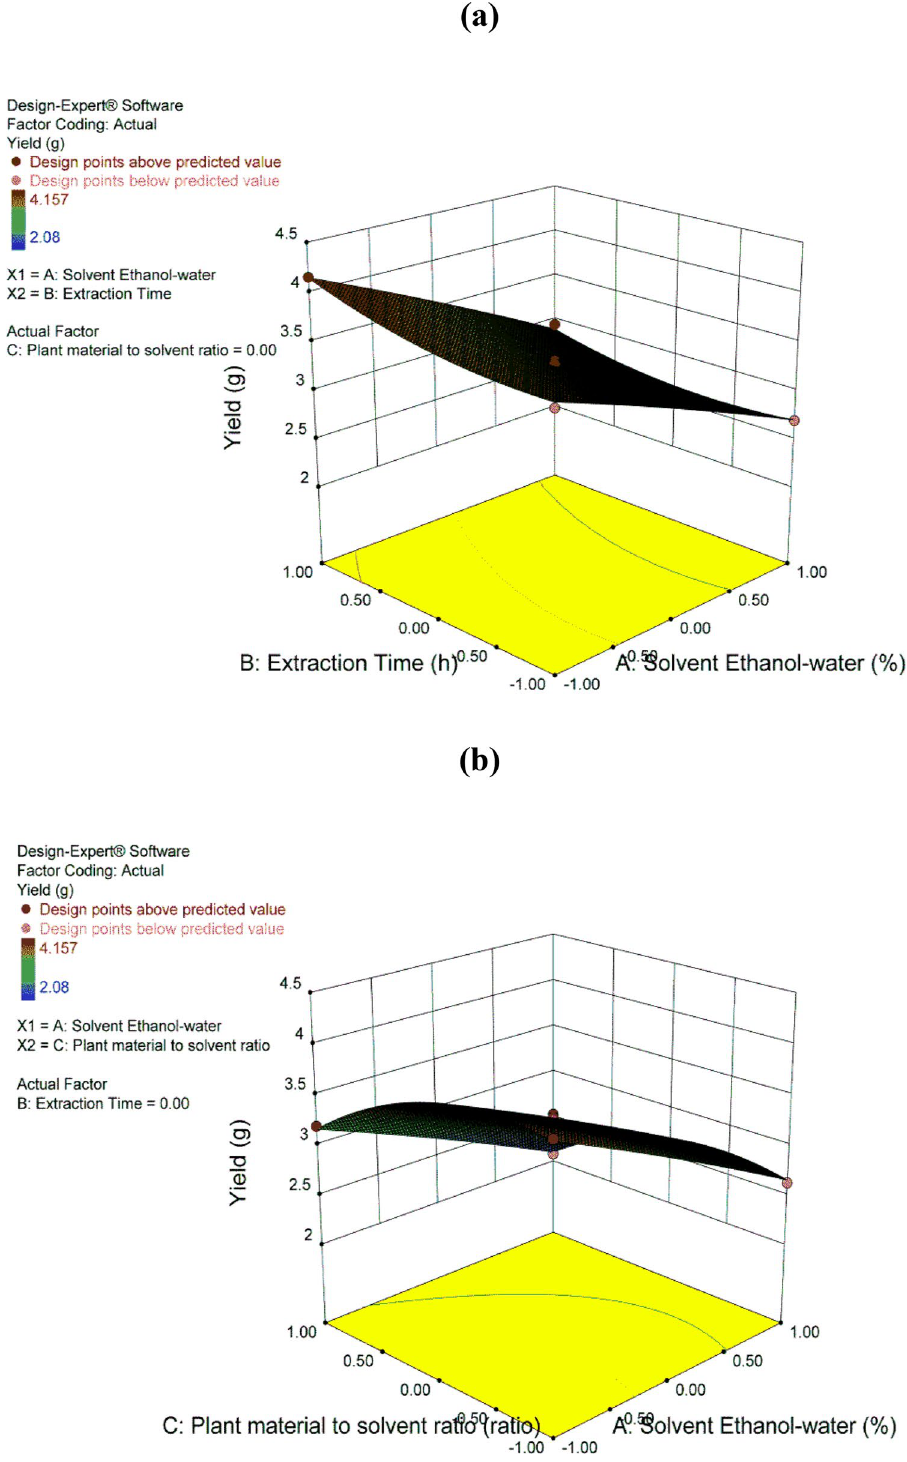
Figure 2. 3D response surface plots for the yield (Y 1 ). ( a ) Effect of A (ethanol/water ratio), B (extraction time) and their interaction on the yield. ( b ) Effect of A (ethanol/water ratio), C (material/solvent ratio) and their interaction on the